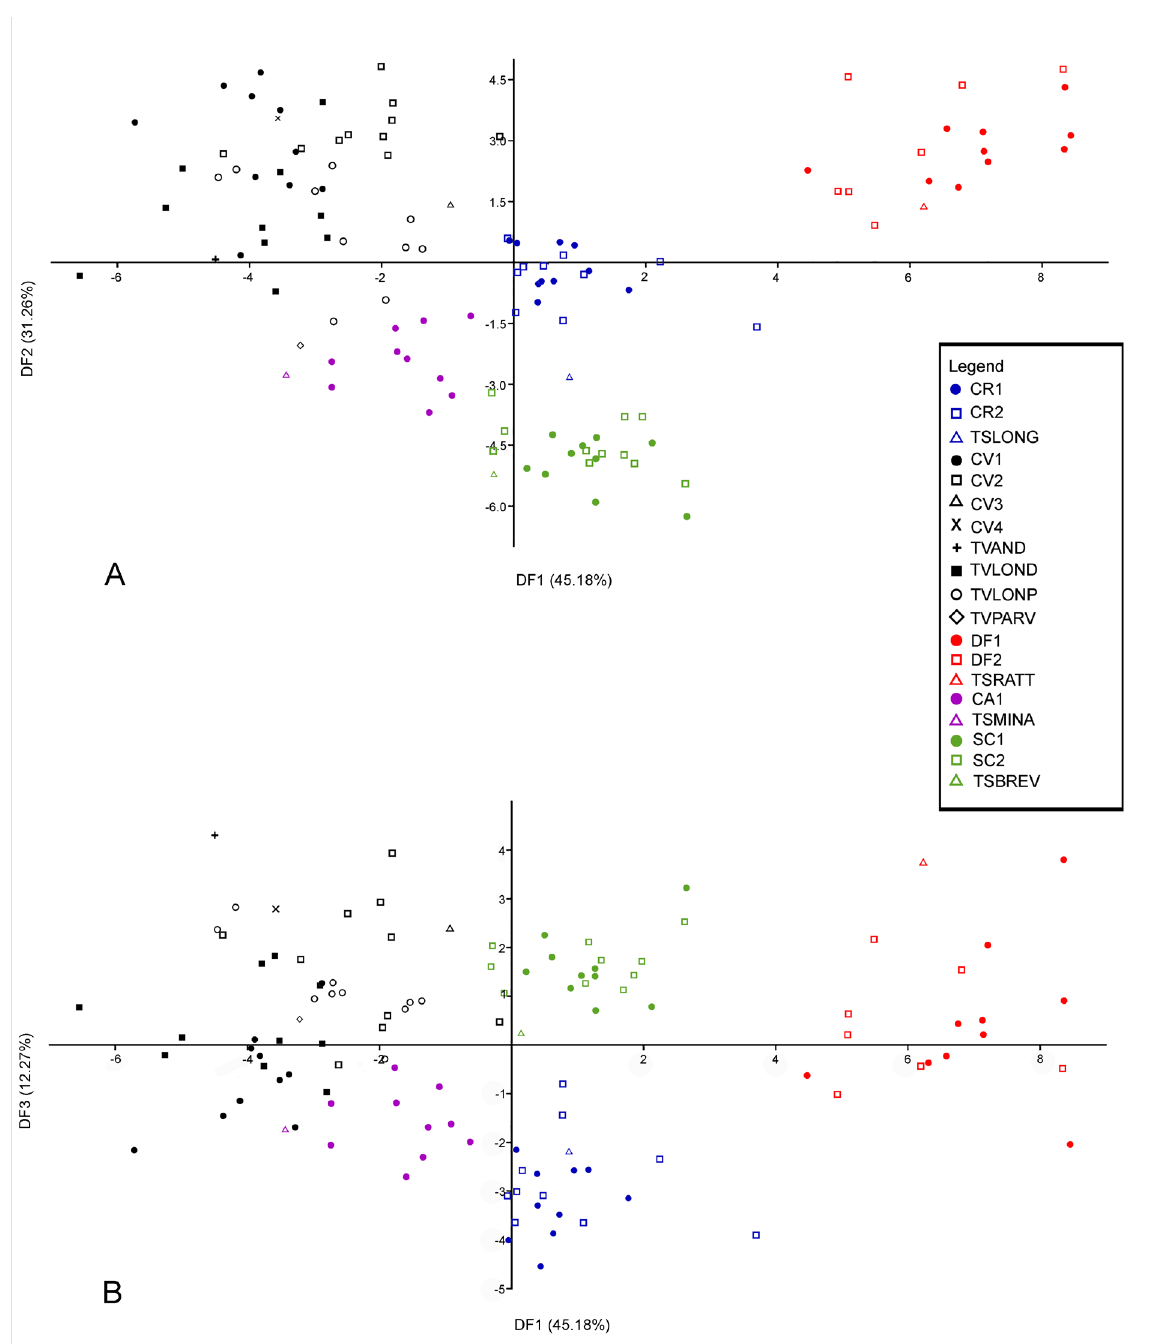
Fig. 3. Scatterplots derived from Discriminant Analysis of 11 natural populations and eight type specimens of the Stachytarpheta longispicata complex. A . Plot of Axis 1 vs Axis 2. B . Plot of Axis 1 vs Axis 3. For explanation of OTUs see Table